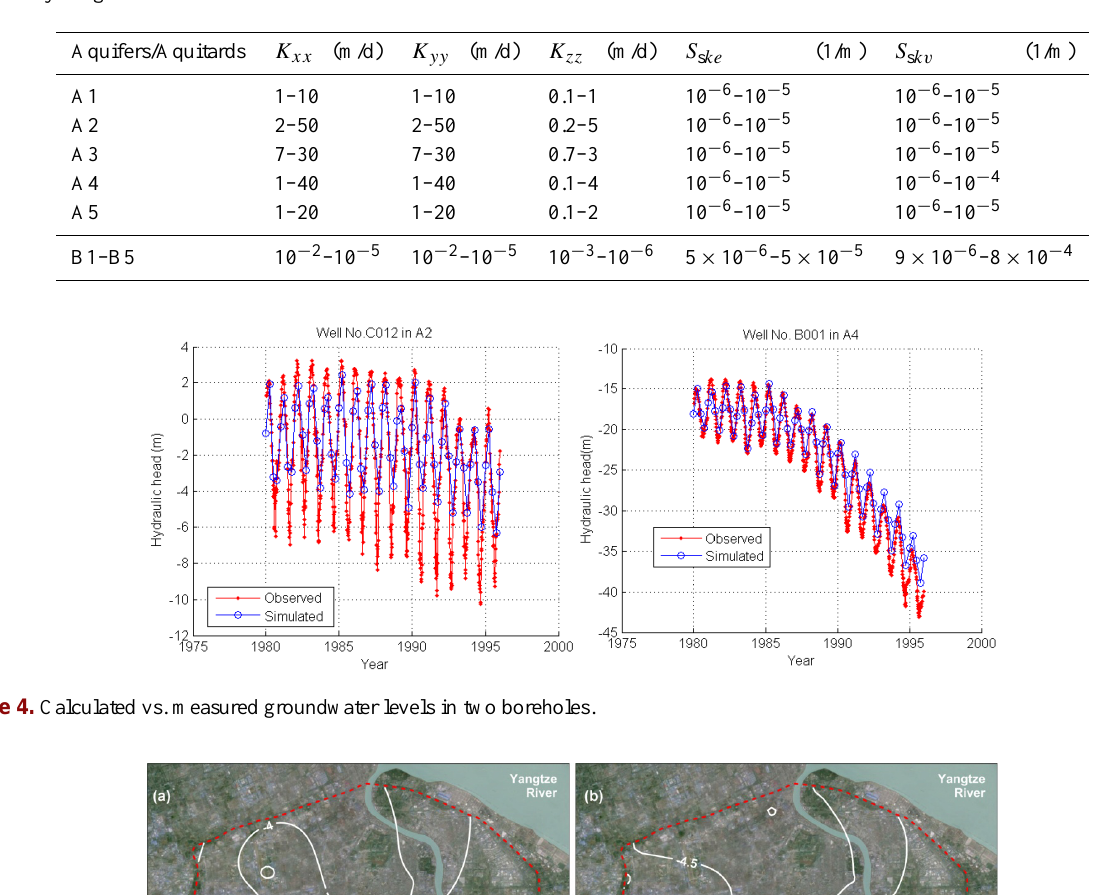
Table 1. Hydro-geo-mechanical Parameters Used in the Final Simulation of the 3-D Groundwater Flow and Geomechanical Models.